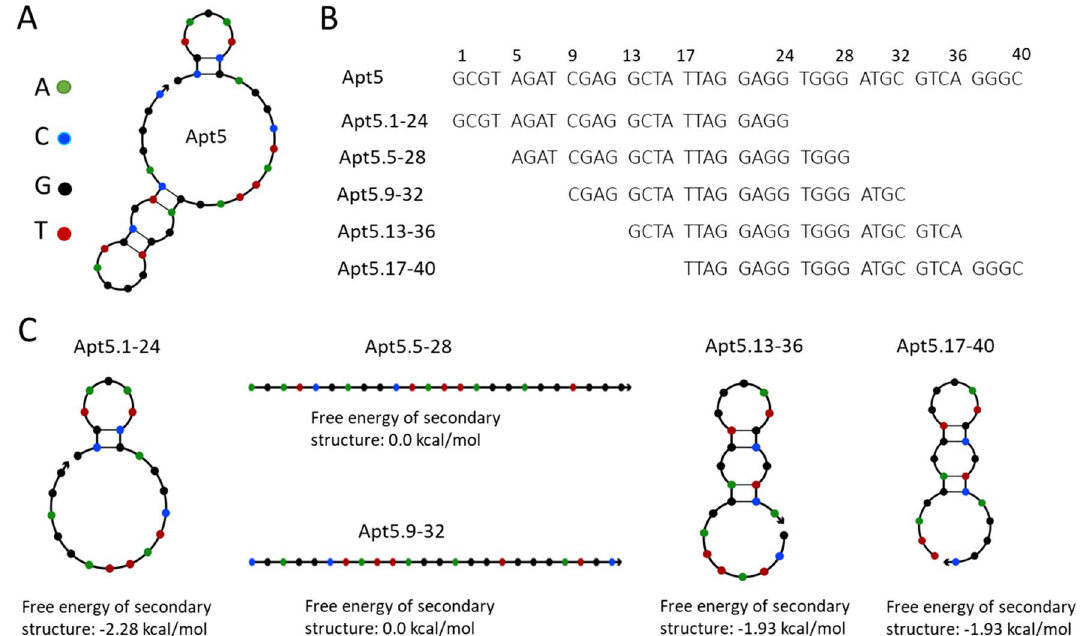
Figure 2. NUPACK characterization of ThT aptamer candidates 14 . ( A ) NUPACK predicted secondary structure of the Apt5. ( B ) The sequence of Apt5 and its fragments. ( C ) NUPACK predicted secondary structures of five truncated versions of